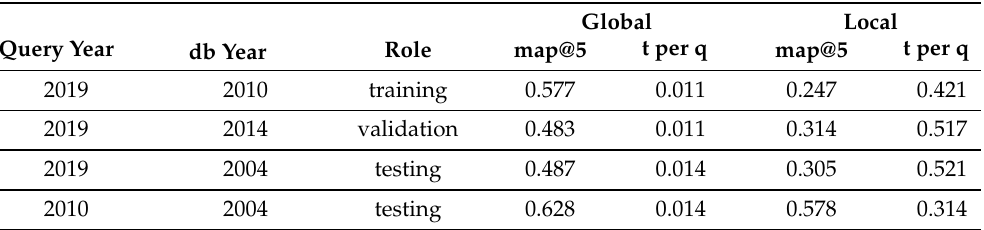
Table 7. The map@5 results for the single source database global and local descriptors with noise σ = 0.01.